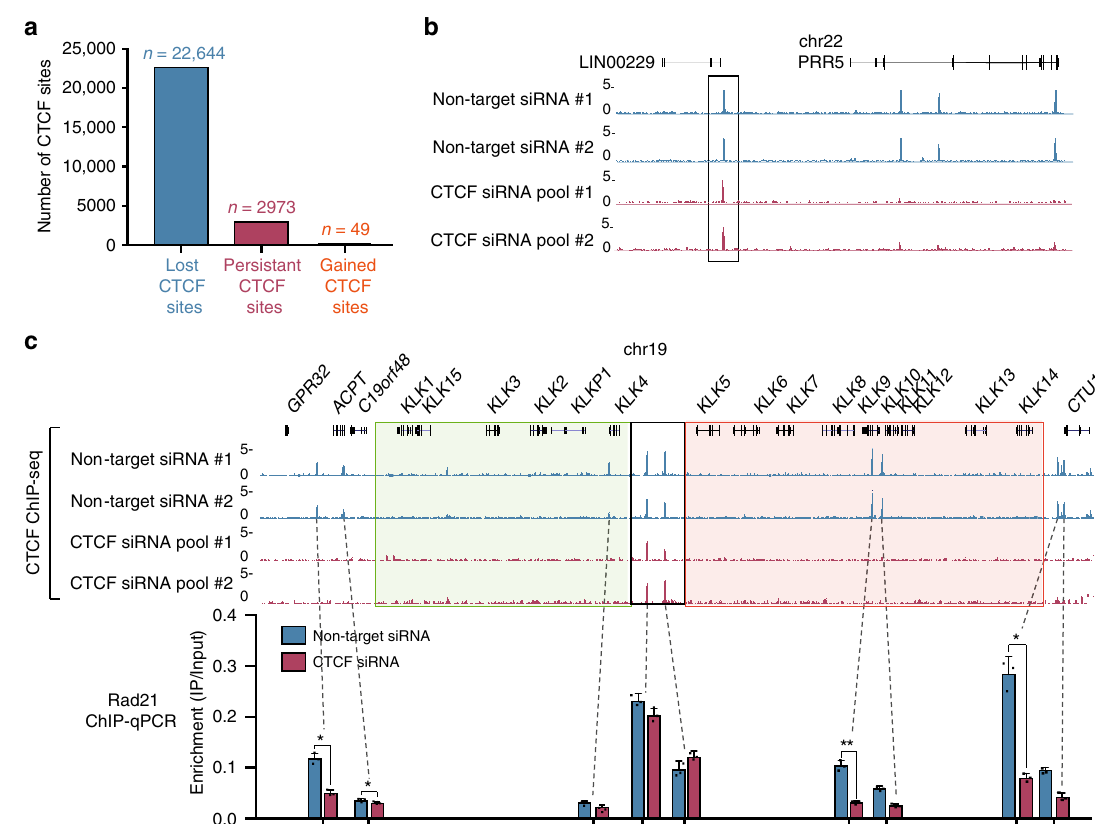
Fig. 4 A subset of CTCF binding sites is more resistant to CTCF depletion. a Bar plot quantifying ‘ lost ’ , ‘ persistent ’ and ‘ gained ’ CTCF sites in LNCaP cells. b UCSC genome browser screenshot demonstrating maintenance of CTCF binding at some sites (box) following CTCF knockdown. c CTCF ChIP-seq illustrates CTCF binding at the boundary of the active and silenced regions at the KLK locus is retained following 144 h of CTCF RNAi. All other binding in the region is lost. RAD21 ChIP-qPCR performed after 144 h of control and CTCF RNAi demonstrates that cohesin binding is maintained where CTCF binding is persistent at the KLK locus (* indicates where two-tailed t -test, p < 0.05; n = 2 biologically independent experiments). Source data are provided as a Source Data fi le. Error bars represent SE. Data for technical replicates n = 3 are overlaid as a dot